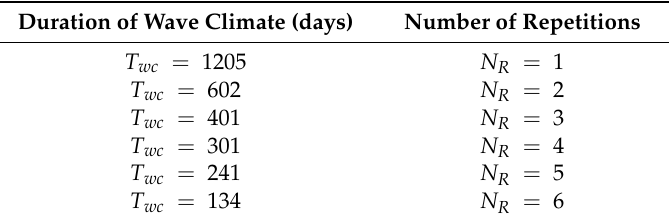
Table 5. Simulated wave climate durations.